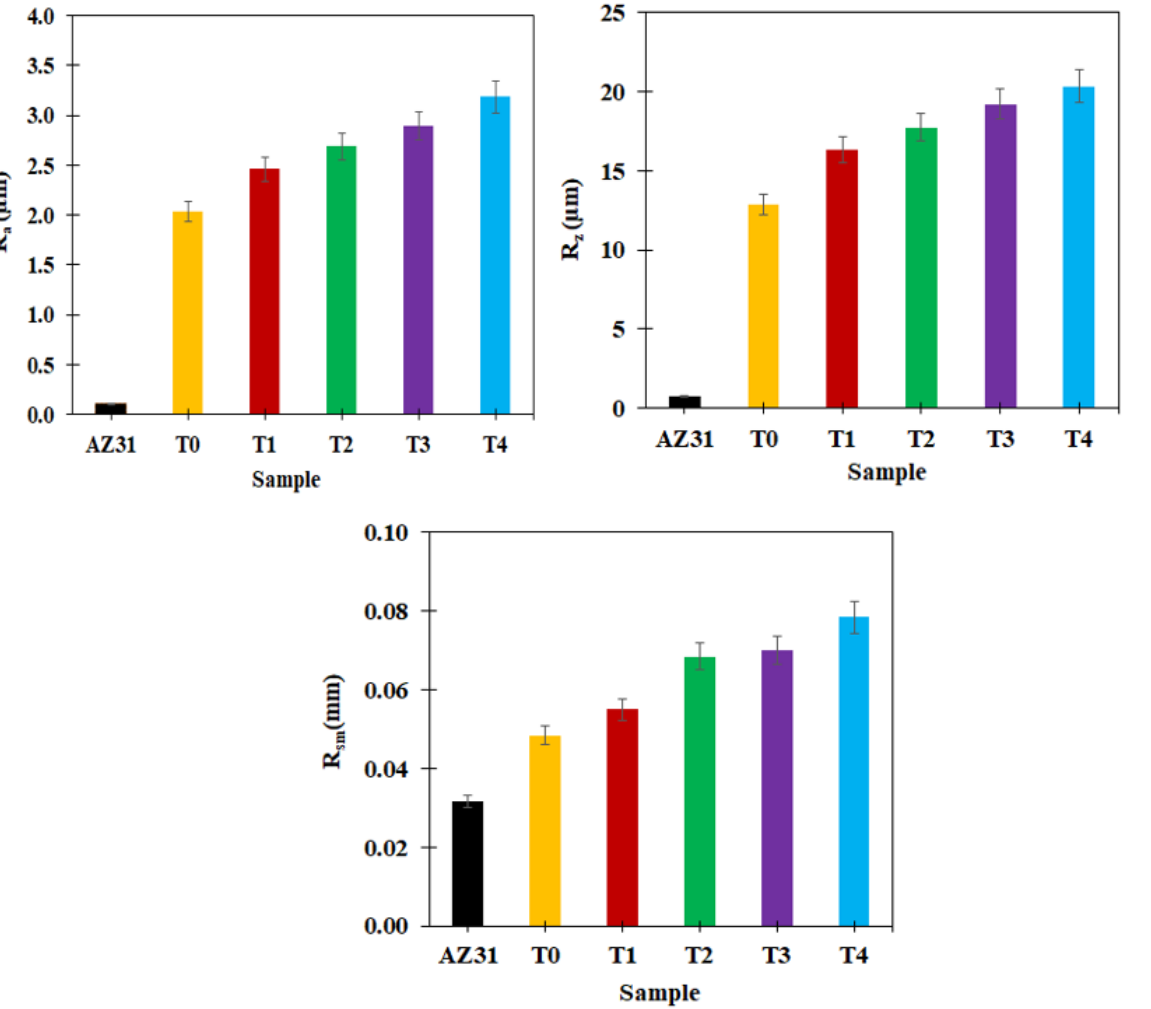
Figure 8. The surface roughness values of PEO-coated specimens at various concentrations of TiO 2 : T0 = 0 g/L, T1 = 1 g/L, T2 = 2 g/L, T3 = 3 g/L, and T4 = 4